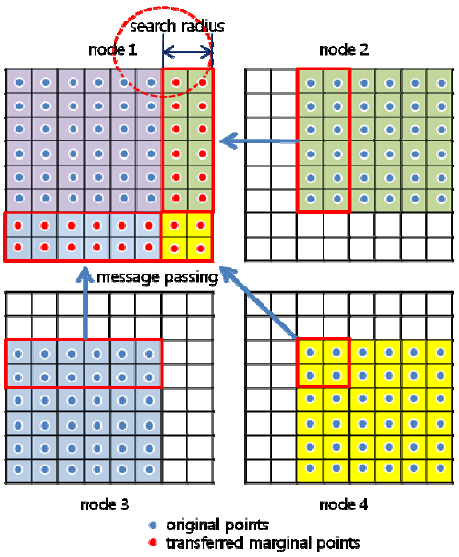
Figure 4. Transfer of marginal points.